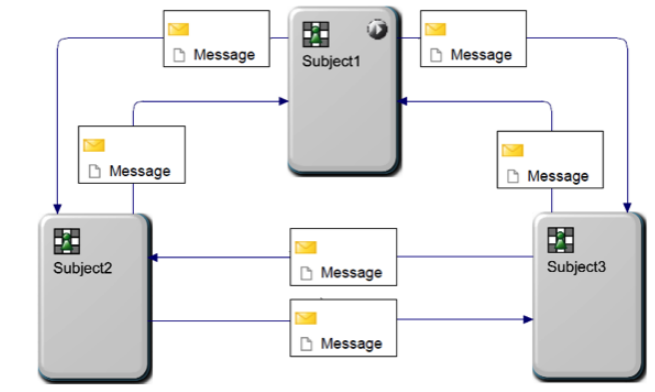
Figure 6. Subject-oriented representation scheme for a 3-party